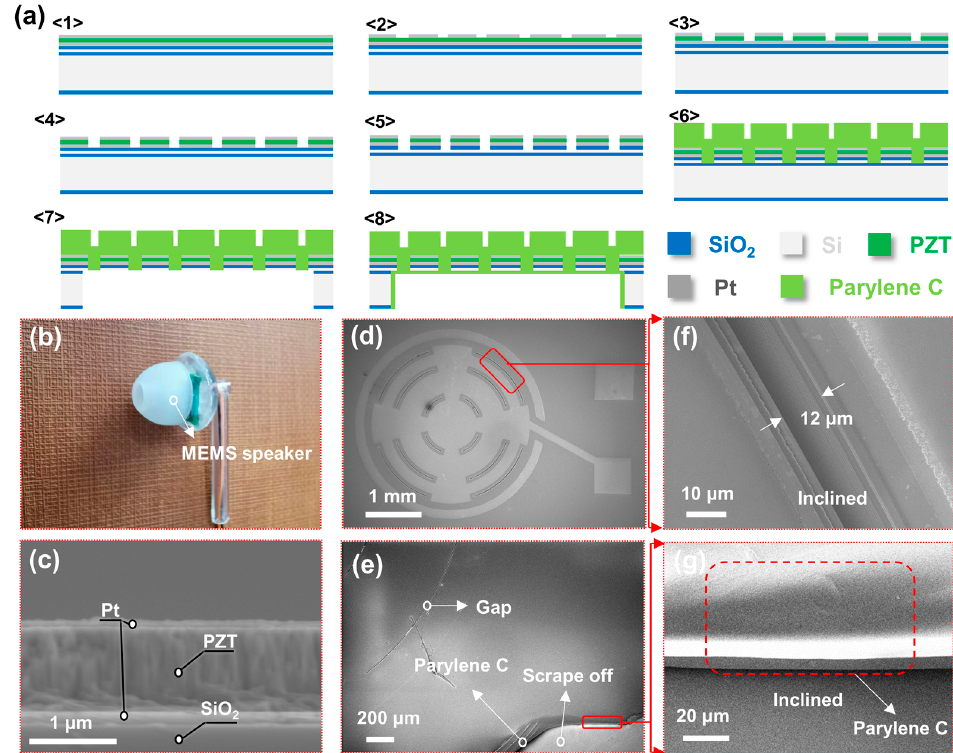
Figure 2. Preparation process and SEM images of the piezoelectric MEMS speaker combining function of silent alarm. ( a ) Process of fabricating the proposed device: (1) materials, (2) etching the upper electrode, (3) wet etching the PZT, (4) etching the lower electrode, (5) etching gaps on the upper surface, (6) depositing thick parylene C, (7) etching the back cavity, (8) depositing thin parylene C. ( b ) Encapsulated speaker. Scanning electron microscopy (SEM) images of ( c ) PZT, ( d ) the whole surface of the device without parylene C, and ( e ) the deposited parylene C, and ( f ) the inclined gap, and ( g ) the inclined view of parylene C section.